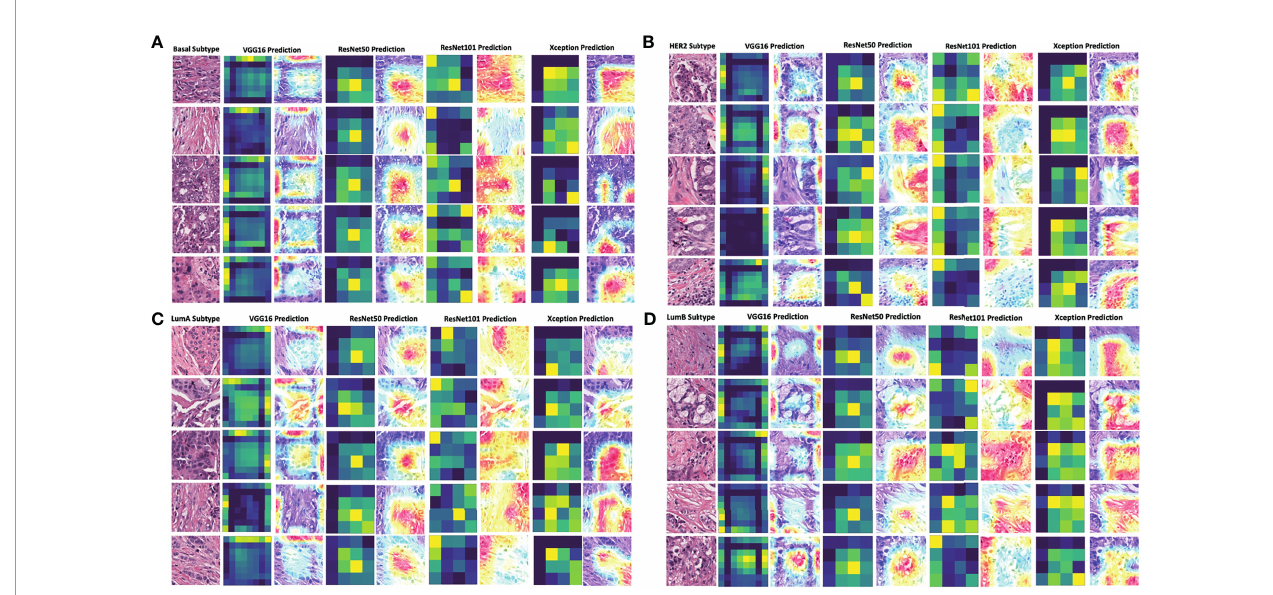
FIGURE 5 | Grad-CAM visualization of deep learning models in four breast cancer subtypes. The visualization of each model ’ s prediction for the same set of images from fi ve patients with breast cancer of the basal subtype (A) , HER2 subtype (B) , luminal A subtype (C) , and luminal B subtype (D) . The heatmap in dark green and yellow colors was plotted together with the merged images of the original and activated heatmaps. The activation levels in the merged images are shown with a gradient of red, yellow, and blue areas, which the models used to make a classi fi cation decision. LumA: Luminal A; LumB: Luminal